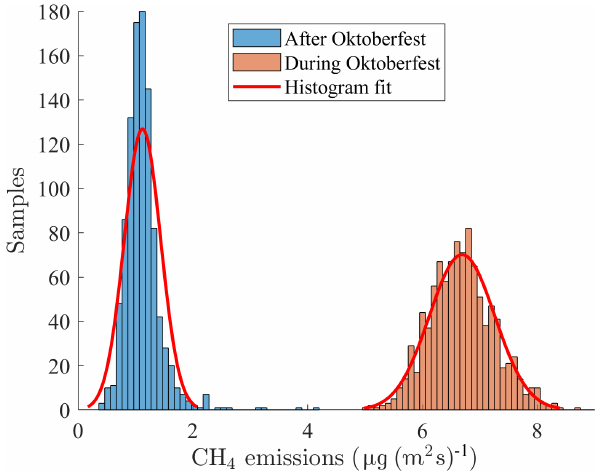
Figure 9. CH 4 emission estimates for a weekday (green) and a weekend day (black) including a fitted normal distribution (red line).